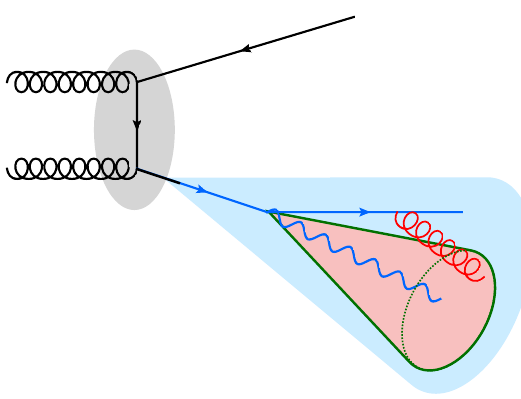
Figure 1 . Pictorial representation of the factorization theorems (2.1) and (5.1). The gray blob represents the hard function, which describes the production of an energetic parton, which then fragments into a photon plus additional radiation (blue region), as encoded by the cone fragmentation function F i → γ in (2.1). For small isolation energy, this function factorizes further. The energetic partons (blue lines) produced in the fragmentation are part of the jet function J i → γ + l and must lie outside the isolation cone. These partons can then radiate soft partons (red) into the isolation cone (green). This radiation is encoded in the functions U l , which depend on the directions and color charges of the energetic